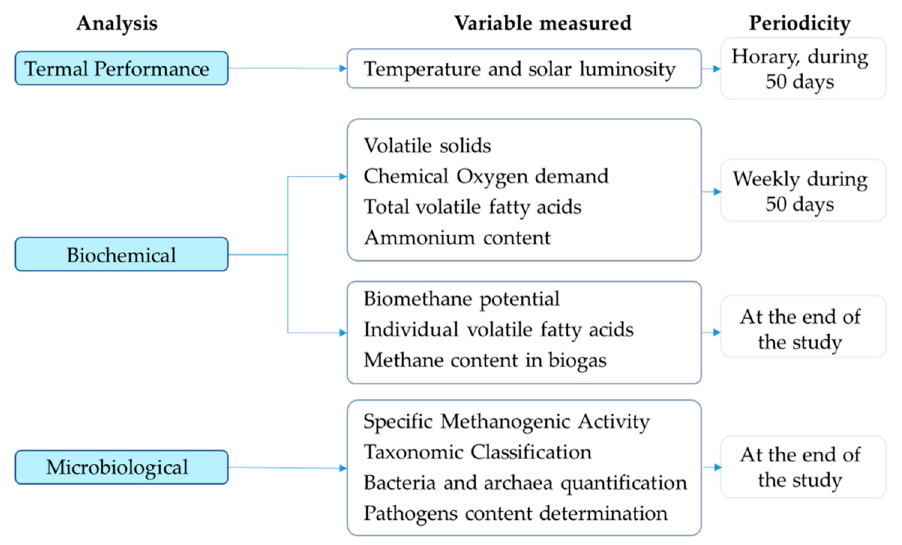
Figure 2. Methodology summary: analysis, variables measured and periodicity during biodigester monitoring.